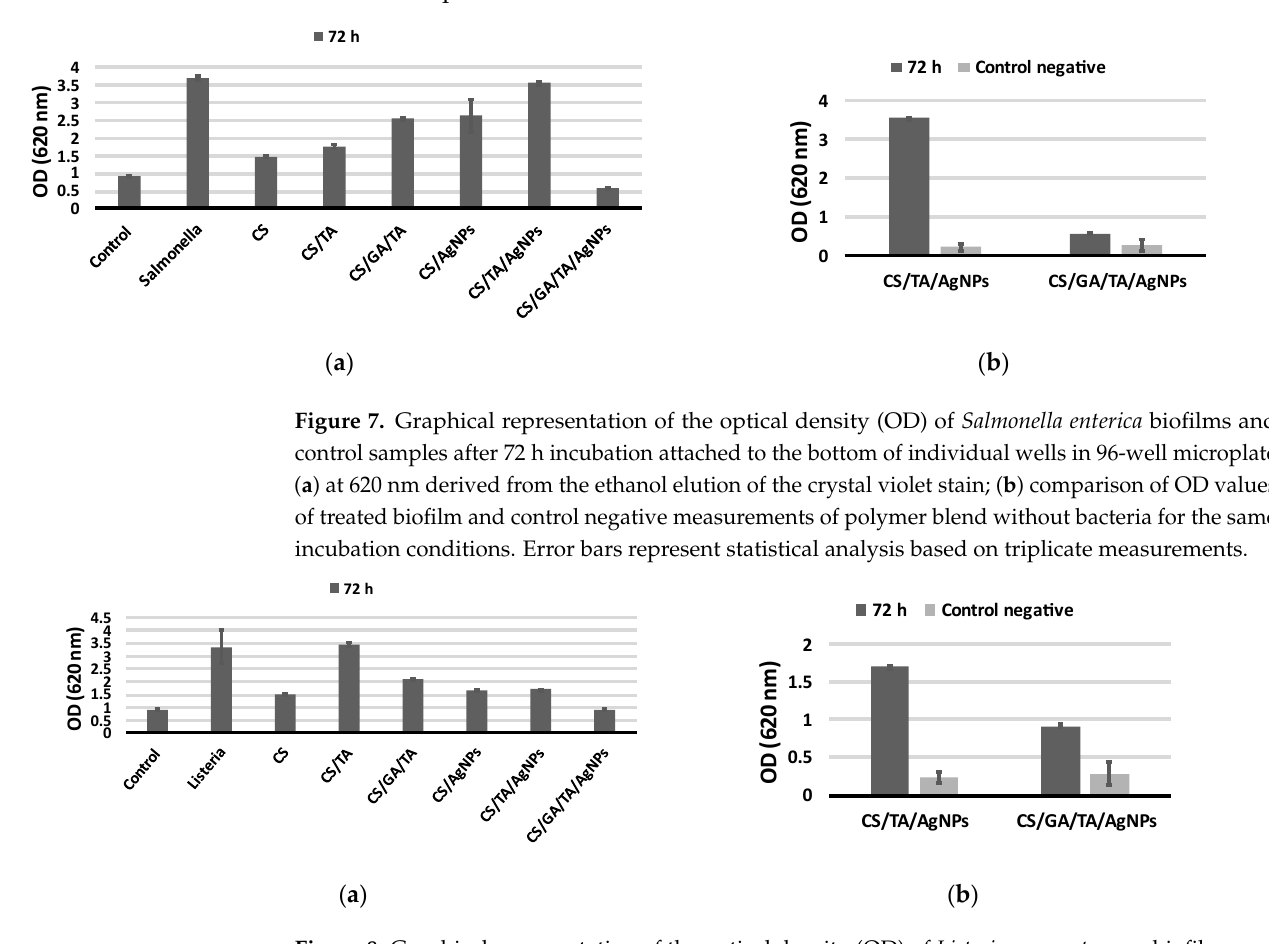
Figure 8. Graphical representation of the optical density (OD) of Listeria monocytogenes biofilms and control samples after 72 h incubation attached to the bottom of individual wells in a 96-well microplate ( a ) at 620 nm derived from the ethanol elution of the crystal violet stain; ( b ) comparison of OD values of treated biofilm and control negative measurements of polymer blend without bacteria for the same incubation conditions. Error bars represent statistical analysis based on triplicate measurements.